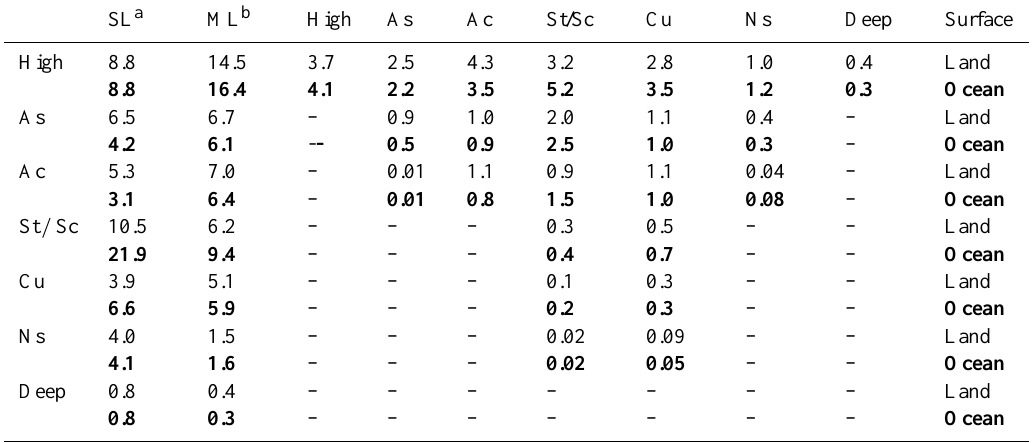
Table 1. Globally averaged overlapping percentages of different cloud types over land and ocean during daytime. SL a ML b High As